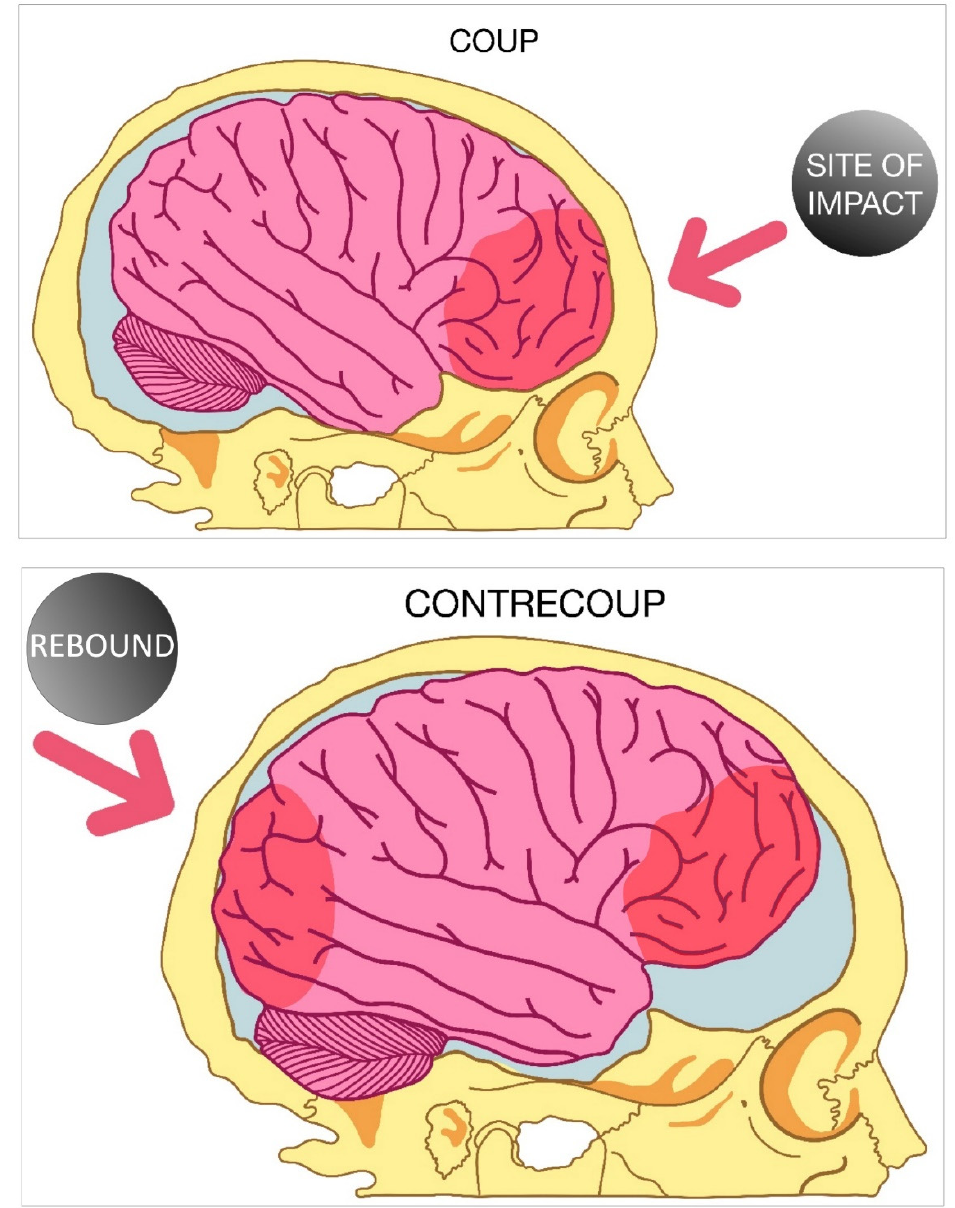
Figure 1. Coup contrecoup traumatic brain injury. The coup portion of the injury occurs when the movement of the head stops abruptly and the brain continues to move in the forward direction so that it hits the skull. The contrecoup portion further compounds the damage as the brain bounces off the skull and hits the side of the skull opposite the side of initial impact.